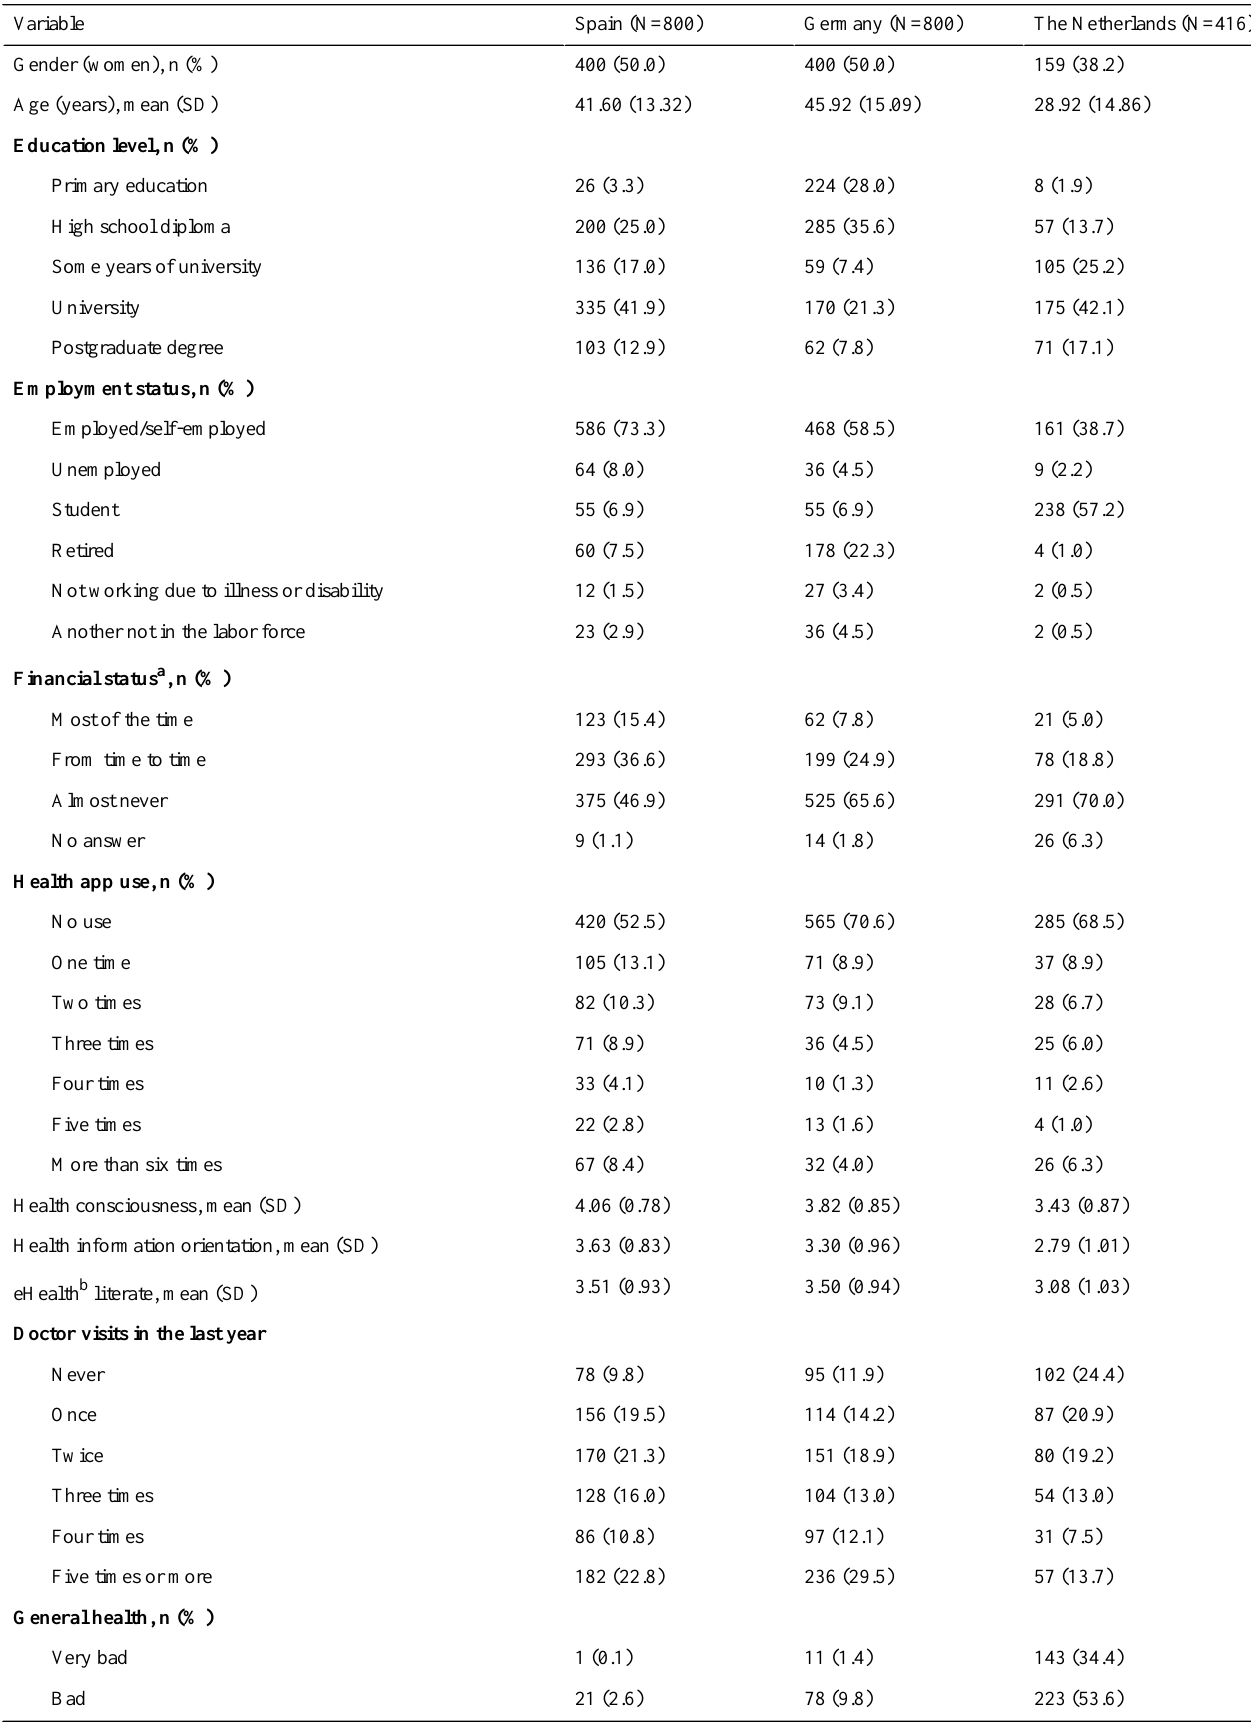
Table 2. Descriptive information about the participants per country.